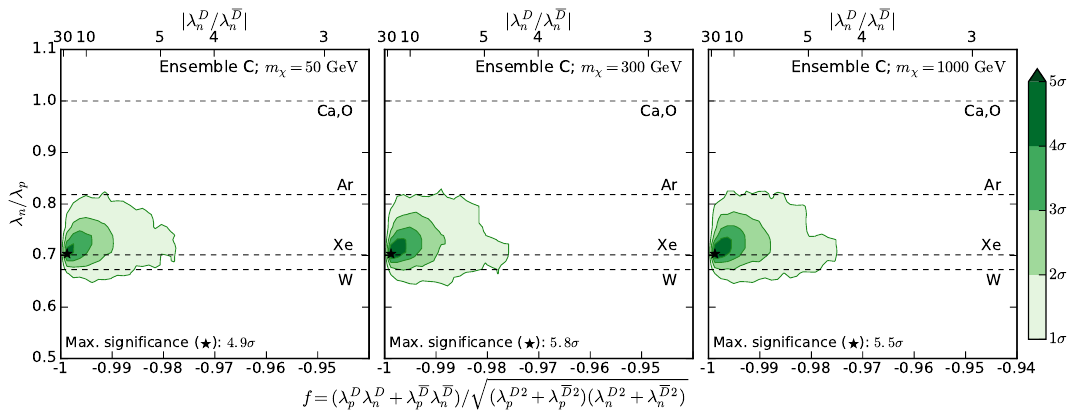
Figure 3 . Median signi(cid:12)cance for discriminating Dirac from Majorana DM using ensemble C (Xe + Ar + CaWO 4 ). As (cid:12)gure 1, but for ensemble